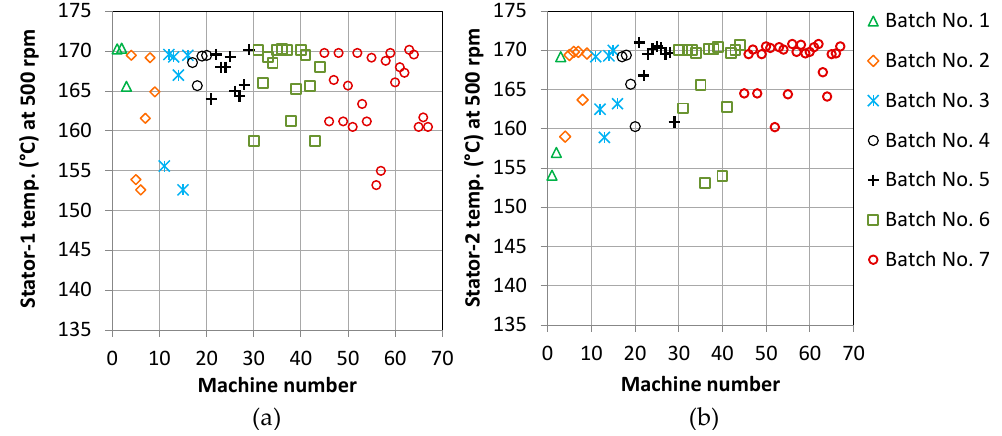
Figure 5. Winding temperature measured for each stator at 500 rpm for each AFPMSM: ( a ) Stator-1; ( b ) stator-2. Energies 2019 , 12 , x FOR PEER REVIEW